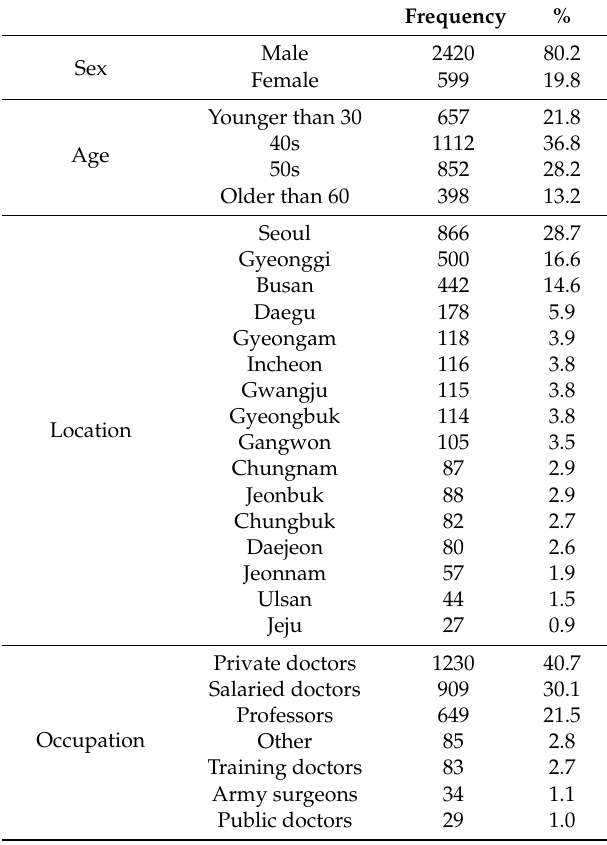
Table 1. Demographic characteristics of the survey respondents.